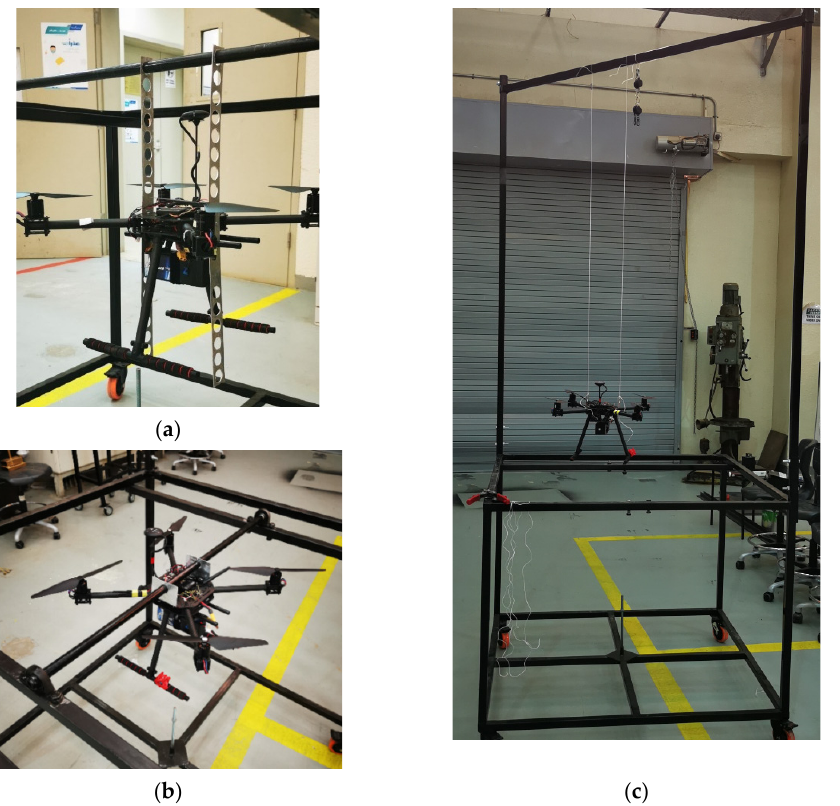
Figure 7. Axes about which the moments of inertia were to be determined.